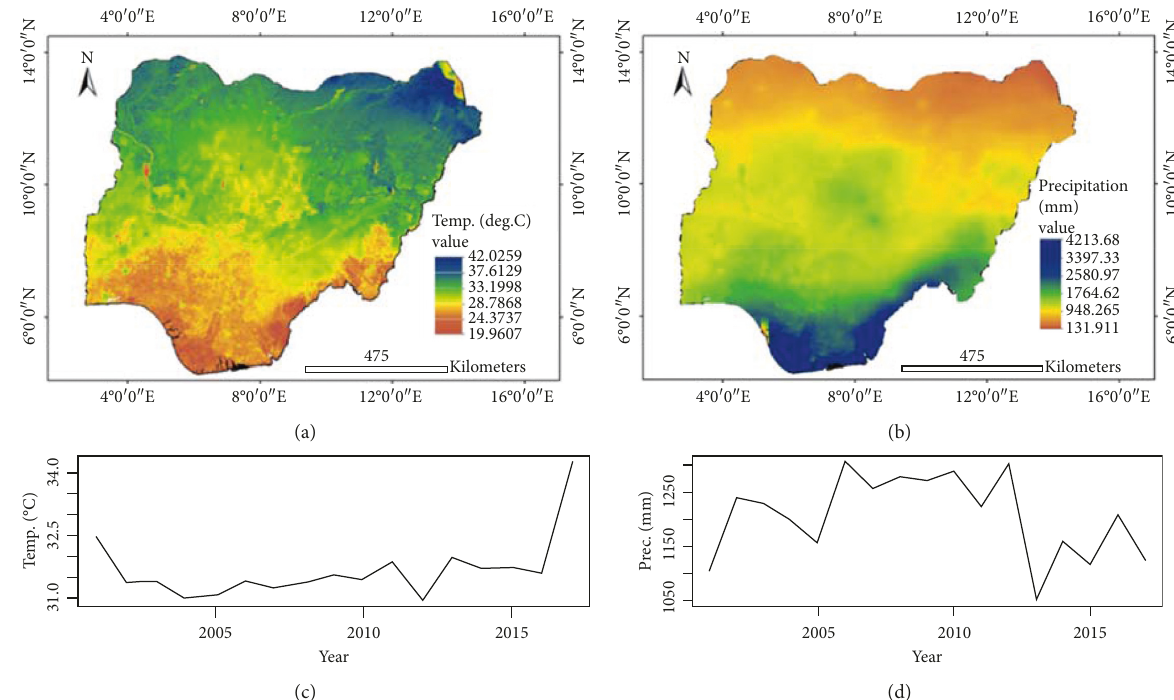
Figure 5: Pattern of rainfall and temperature in the study area from 2001 to 2017: (a) mean annual temperature; (b) mean annual precipitation; (c) interannual variability in temperature; (d) interannual variability in